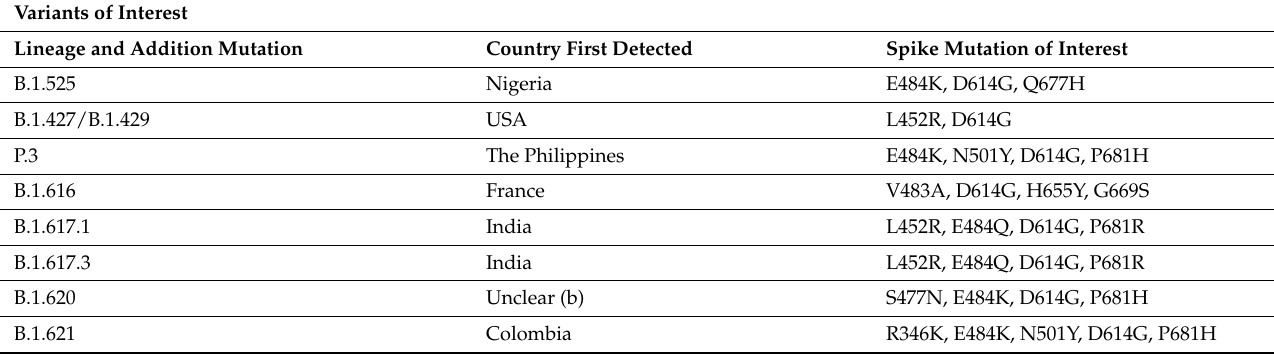
Table 3. Variants of Interest according to the latest classification by ECDC